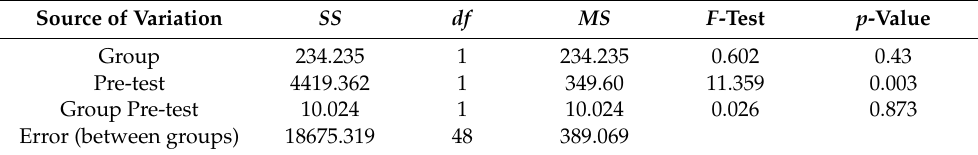
Table 3. Test results of homogeneity of regression coe ffi cients in the pre-test group.